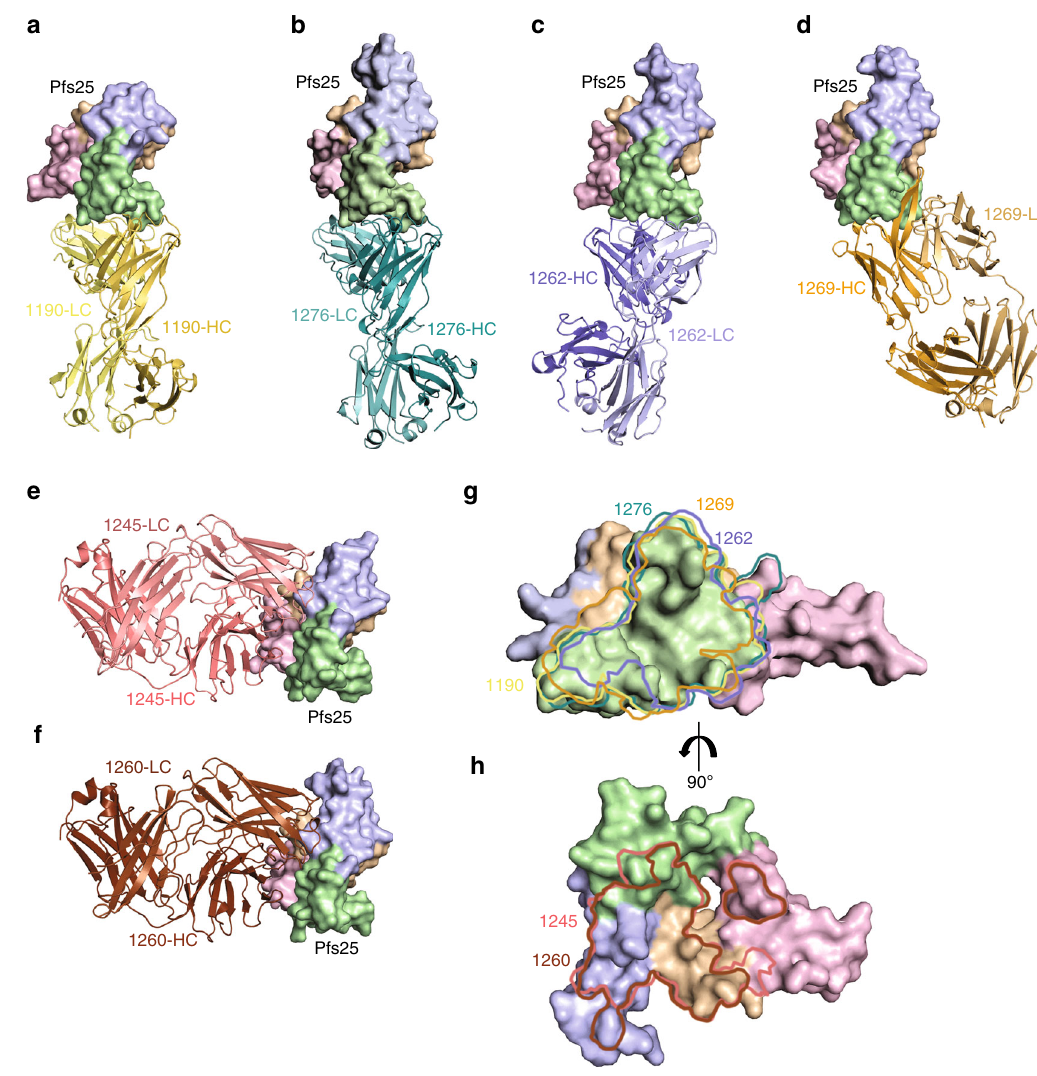
Fig. 3 Crystal structures of six mAbs in complex with Pfs25. Crystal structures of a 1190, b 1276, c 1262, d 1269, e 1245, and f 1260 in complex with Pfs25. All crystal structures are shown according to the same Pfs25 orientation. Pfs25 is represented as surface and EGF-like domains 1 – 4 are colored in wheat, pink, green, and blue, respectively. g Site 1a epitopes for 1190, 1262, 1269, and 1276 antibodies traced onto the surface of Pfs25. h Site 2 epitopes for 1245 and 1260 antibodies traced onto the surface of